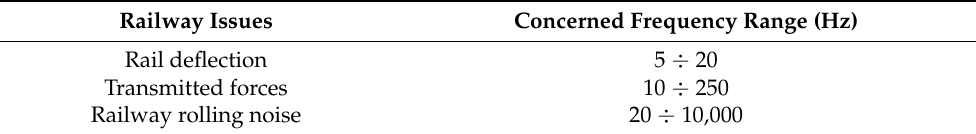
Table 1. Concerned frequency ranges of the various issues related to the dynamic behaviour of the railway